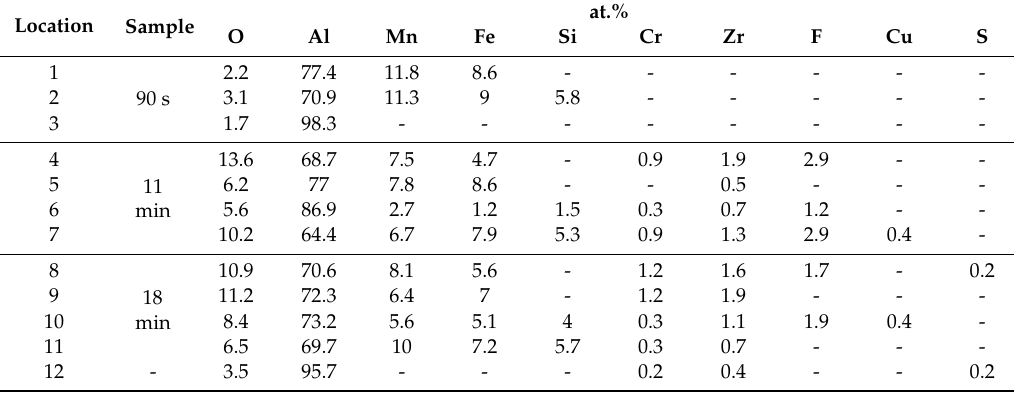
Figure 14. SEM backscattered electron micrographs for AA3003 coated with 10% ST650 conversion coatings prepared at different conversion times: ( a ) 90 s; ( b ) 11 min and ( c ) 18 min at room temperature. The enumerated spots are the locations at which EDS analysis was performed (Table 7). Table 7. The concentrations of elements obtained by EDS analysis at the surface of 10% ST650 (Locations 4–7) and ( c ) 18 min (Locations 8–11). Please note that the latter are the same as Locations